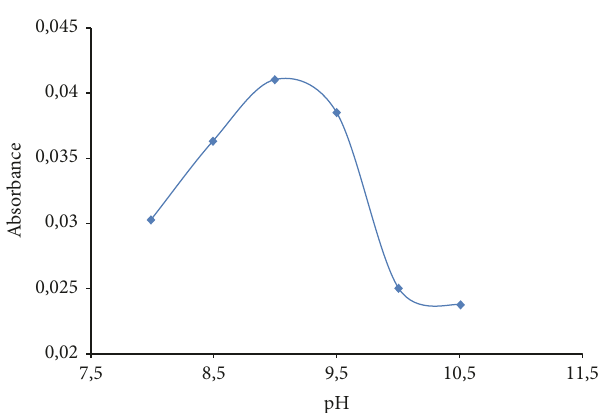
Figure 4: The effect of pH on the extraction of lead with SFODME. Extraction circumstances: Pb: 10 𝜇 gL −1 ; extraction sol- vent, 1-undecanol (100 𝜇 L); sample volume, 10mL; dispersive sol- vent, acetonitrile (200 𝜇 L); % 1.6 NaCl; chelating reagent [PAN], 1 × 10 −4 molL −1 .